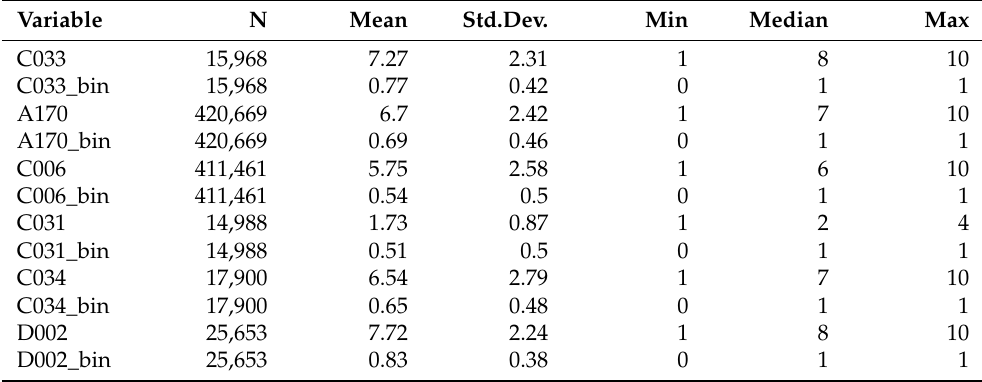
Table A2. Descriptive statistics for the variable to analyze and those most resilient five possible predictors selected after using PCDM, LASSO, and